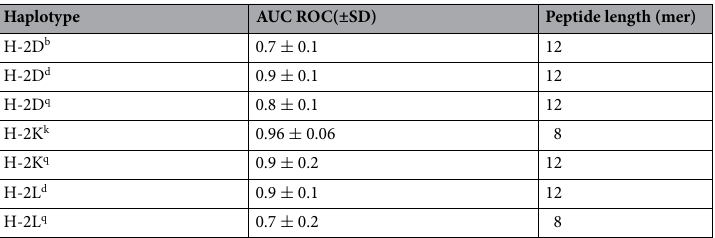
Table 2. AUC ROC scores and minimum required peptide lengths of haplotypes implemented in NAP-CNB. The AUC ROC corresponds to the fivefold cross-validation average of the best configuration obtained through grid-search parametrization. In all haplotypes 128 models were initially generated for lengths of 8, 10 and 12 amino acids with additional fine-tuning for some instances.